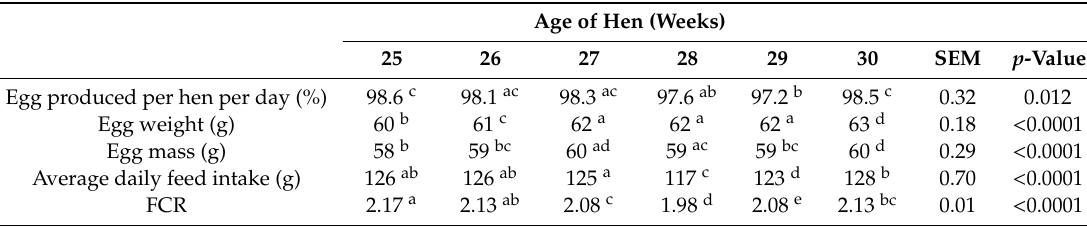
Table 2. Changes in mean hen performance traits of individually caged ISA Brown hens between 25 and 30 weeks of age ( n = 2676).